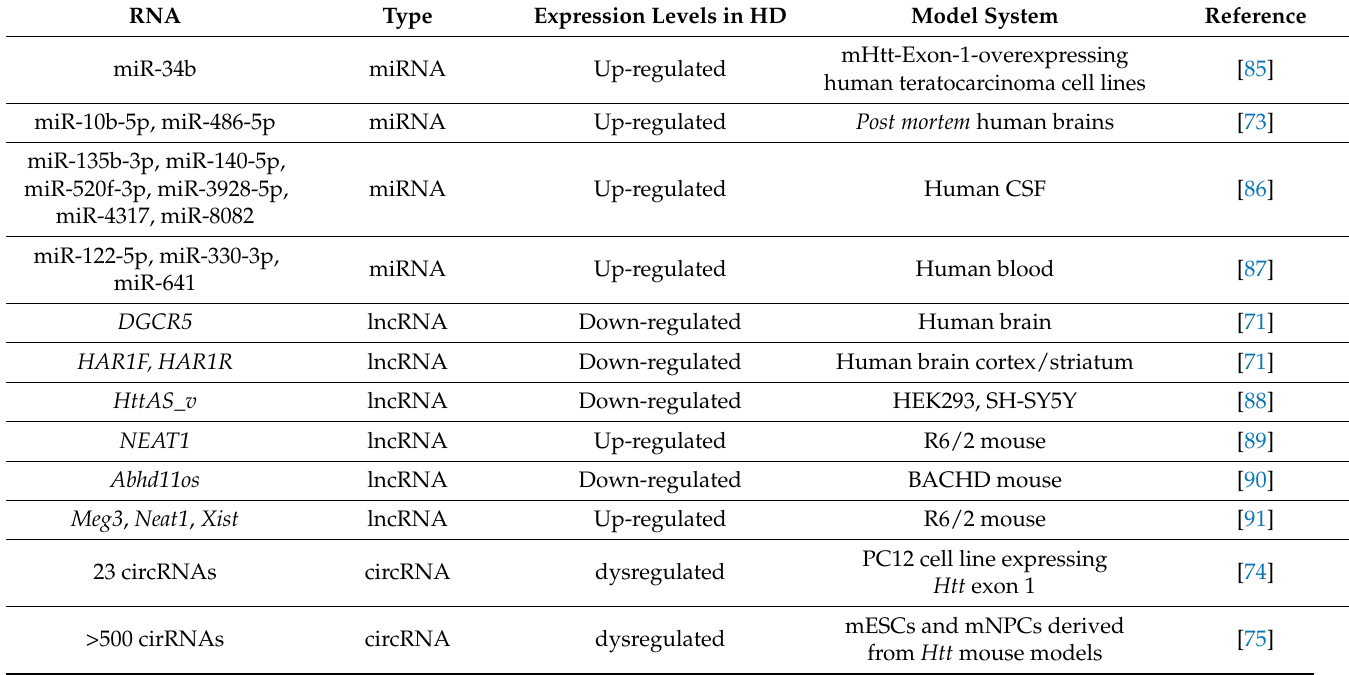
Table 1. Several dysregulated RNAs in Huntington’s